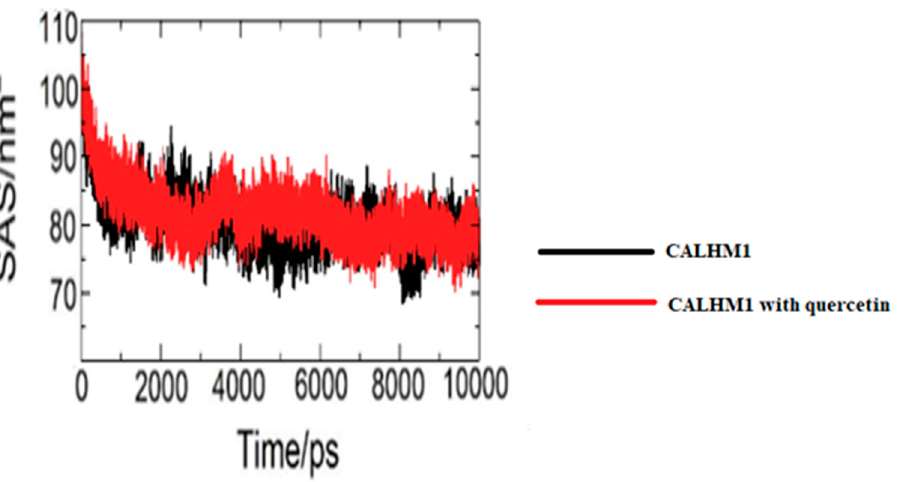
Figure 15. Solvent accessible surface area (SASA) during 10,000 ps of MD simulation of unliganded CALHM1 and CALHM1–quercetin complex.